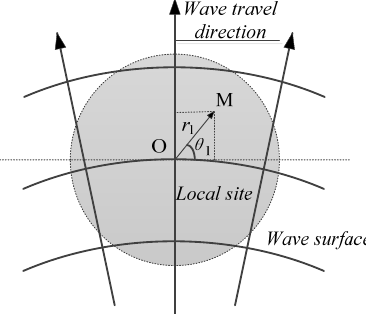
Figure 5. Seismic wave propagation in the local site (plan view).